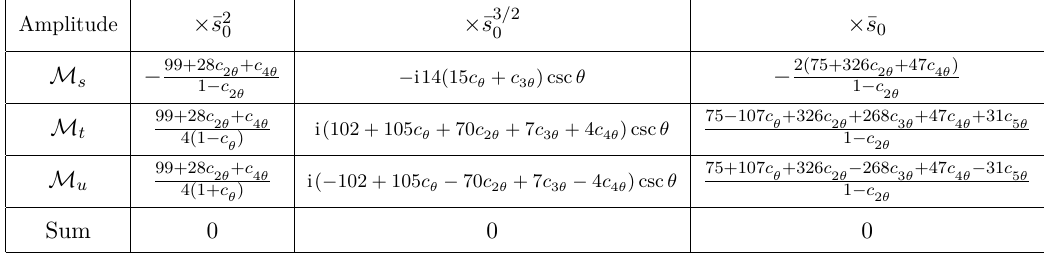
, ¯ s 0 ) are defined by ¯ s 0 = s 0